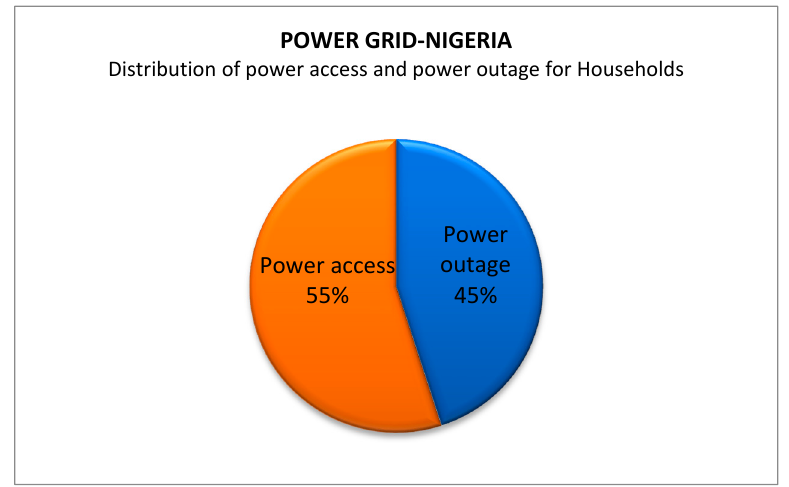
Figure 1. Distribution between households with access to electricity supply and those without (Source: [5]).